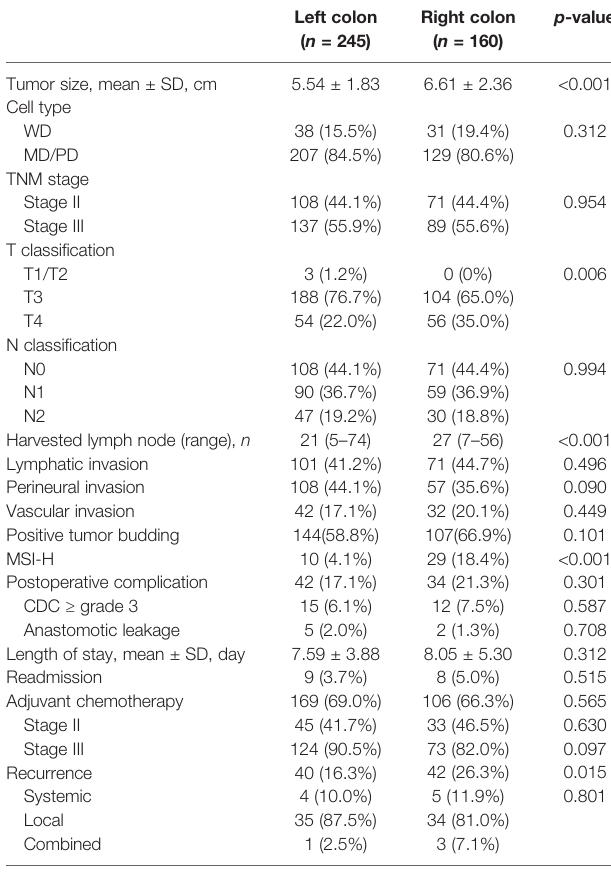
Left colon Right colon ( n = 245) ( n = 160)